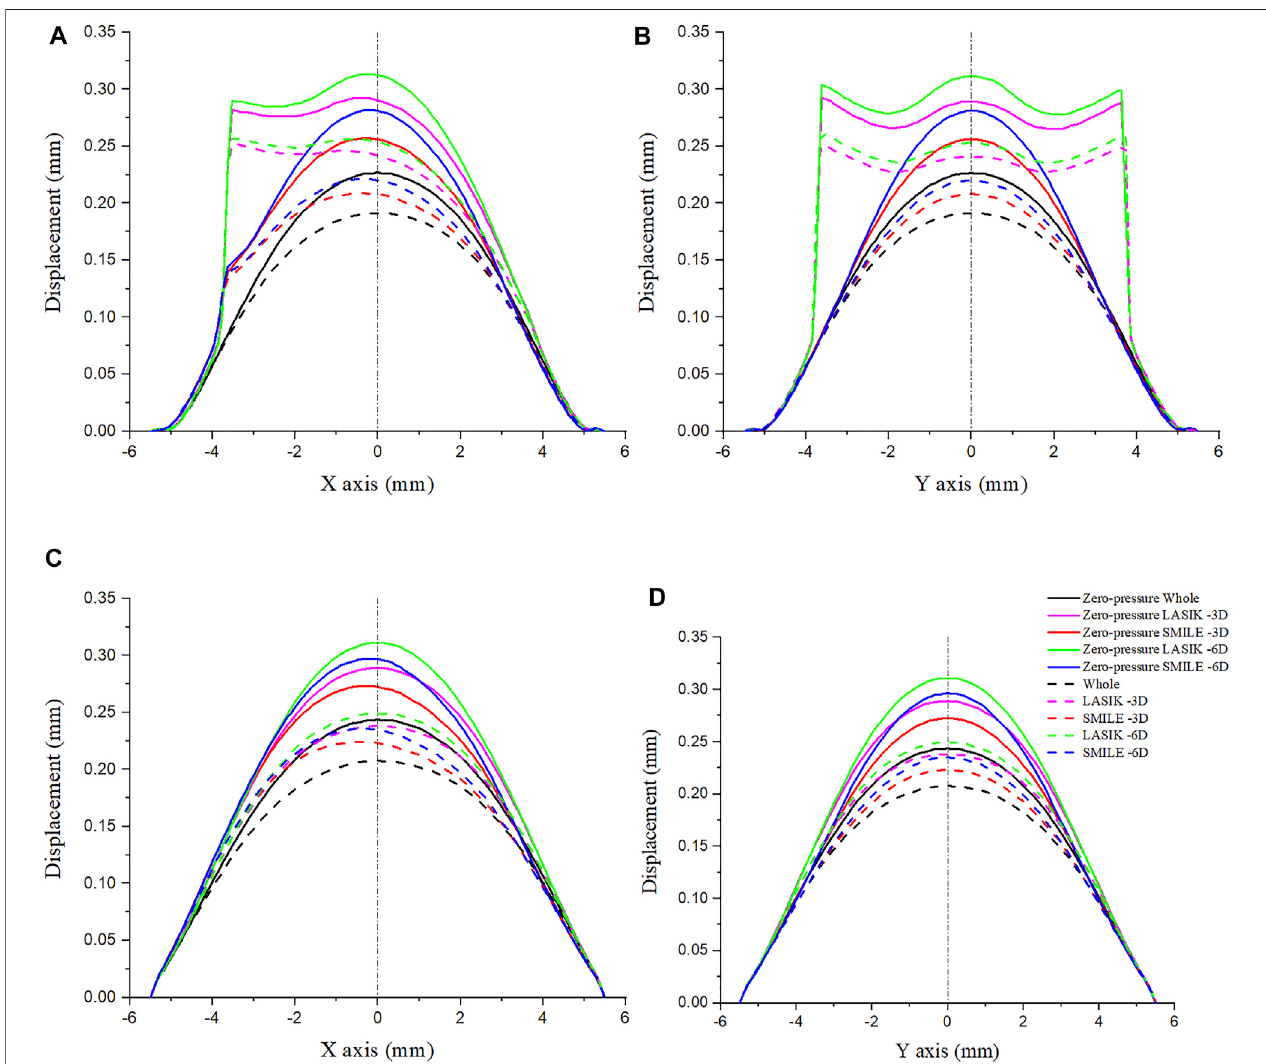
FIGURE 5 | Comparison of displacement on the cornea along the different paths. The IOP was constant at 19 mmHg. (A) Displacement on the anterior corneal surface along the x -axis. (B) Displacement on the anterior corneal surface along the y -axis. (C) Displacement on the posterior corneal surface along the x -axis. (D) Displacement on the posterior corneal surface along the y -axis. (IOP = intraocular pressure; LASIK = laser in situ keratomileusis; SMILE = small-incision lenticule extraction).